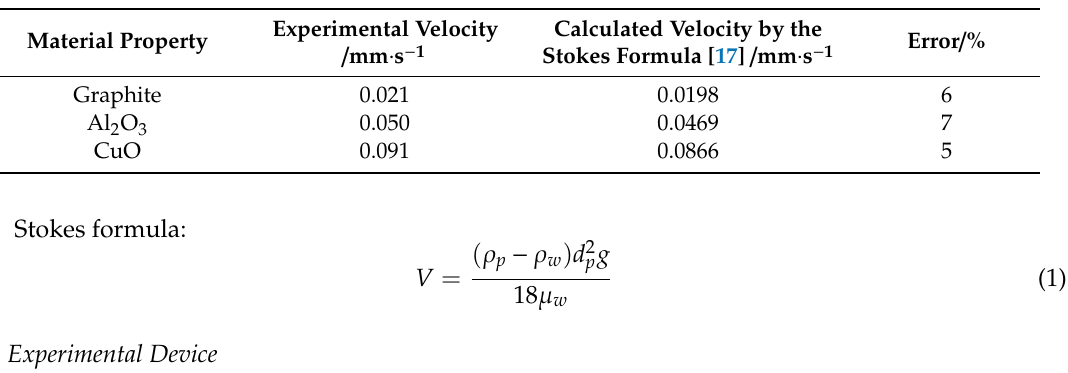
Table 2. The velocity of